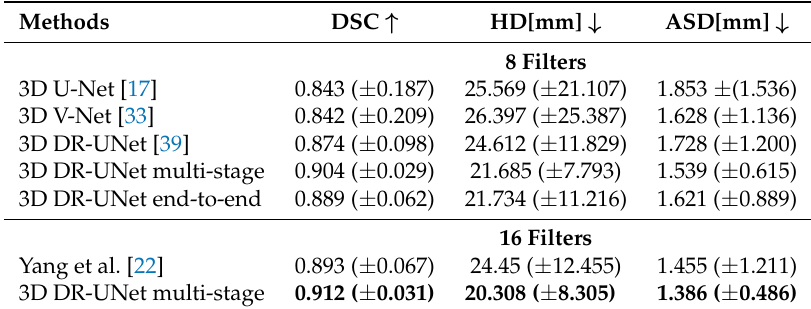
Table 2. Segmentation performance of different network architectures on the test samples from the LASC STACOM 2018 dataset, evaluated using the dice similarity coefficient (DSC), Hausdorff distance (HD) and average surface distance (ASD) metrics (mean ± (std)). Filters denote here the initial number of convolution kernels which used the byeach network.